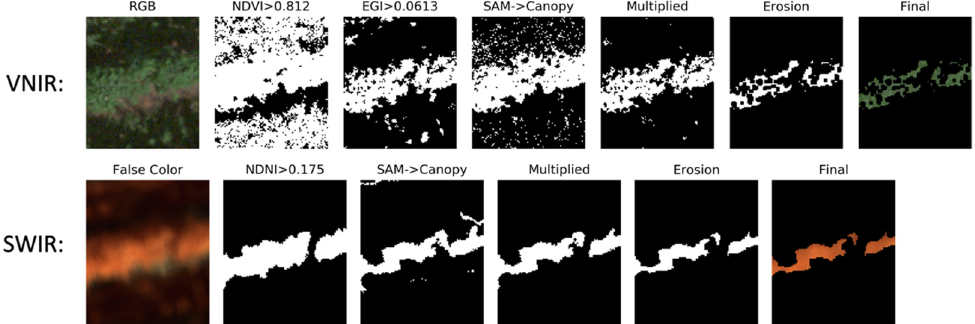
Figure 2. Results of each masking of the grapevine canopy steps, including the threshold masks of multiple vegetation indices, a spectral angle mapper canopy classification mask, and a morphological erosion of the multiplied masks. For the VNIR imagery, the NDVI and EGI were used, and for SWIR, the NDNI was used for the vegetation mask thresholds (NDVI > 0.812, EGI > 0.0613, and NDNI > 0.175, respectively). In each case, the threshold value was quantitatively determined from a vegetation index pixel histogram. The final masks were used to extract the mean canopy spectra of each grapevine in the